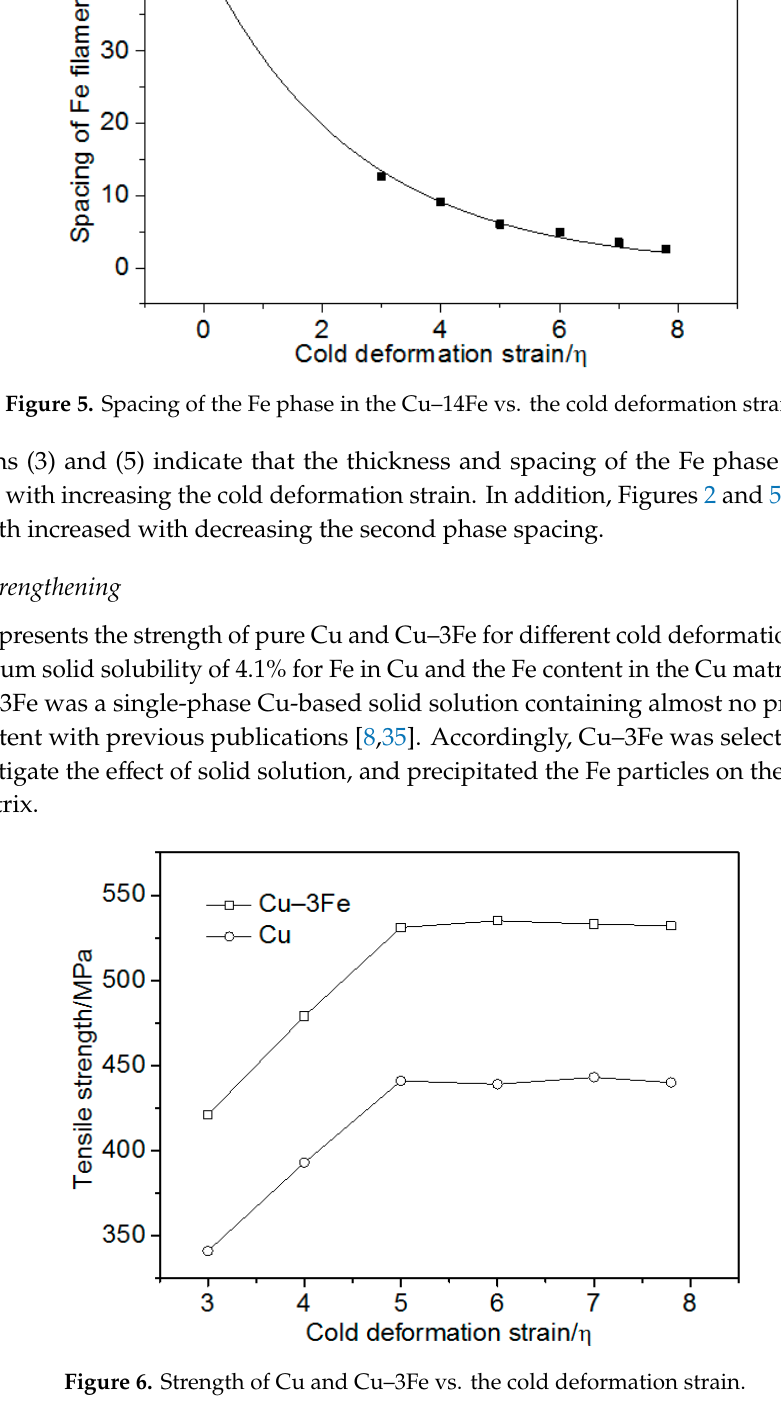
Figure 6. Strength of Cu and Cu–3Fe vs. the cold deformation strain.